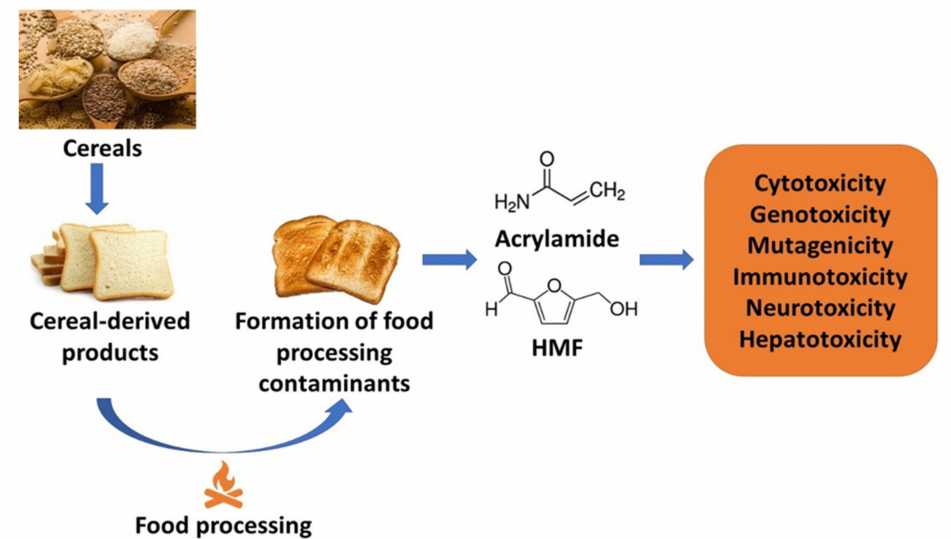
Figure 3. Humans’ exposure to food processing contaminants induces cytotoxicity, genotoxicity, mutagenicity, immunotoxicity, neurotoxicity, and